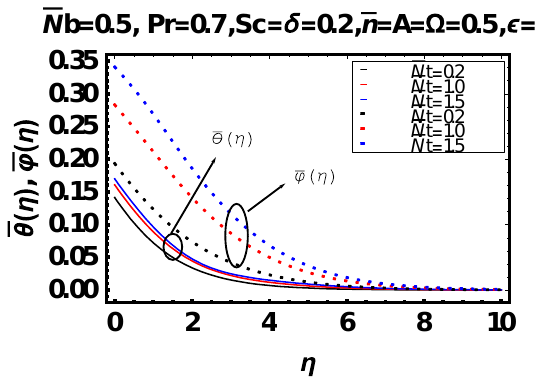
Figure 17. Temperature and concentration profiles for variant α 2 .